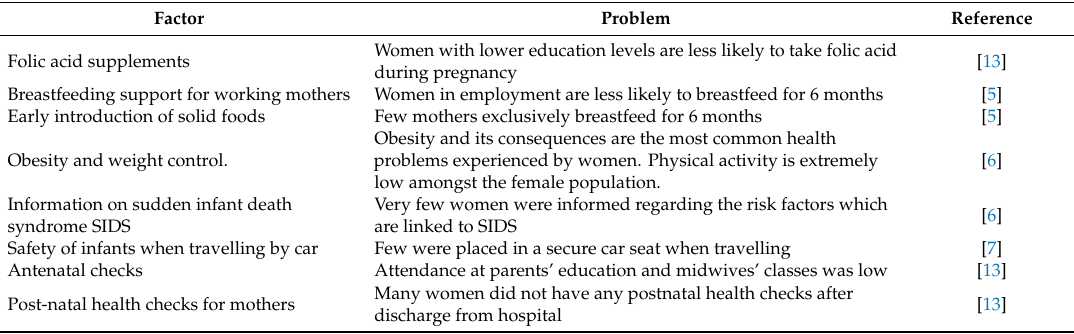
Table 1. Factors and problems influencing maternal and infant health, on which the interview questions were